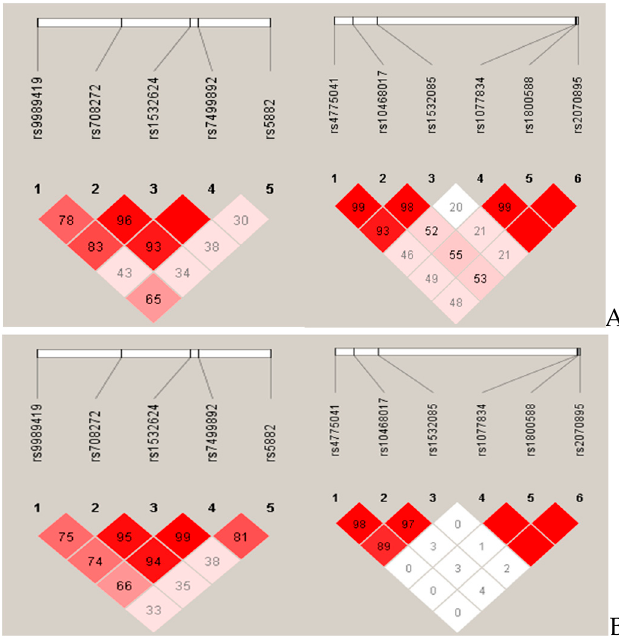
Figure 1. Linkage disequilibrium structure of the 5 studied single nucleotide polymorphisms (SNPs) in CETP and 6 SNPs in LIPC genes in Hungarian Roma ( A ) and general populations ( B ). The blocks were formed by the SNPs of the CETP and LIPC genes. The numbers above the map show the rs numbers of SNPs. The color scheme is a standard Haploview color scheme (white D ′ < 1 and LOD < 2, shades of pink/red: D ′ < 1 and LOD ≥ 2, and bright red D ′ = 1 and LOD ≥ 2). Numbers in the squares are D ′ values.